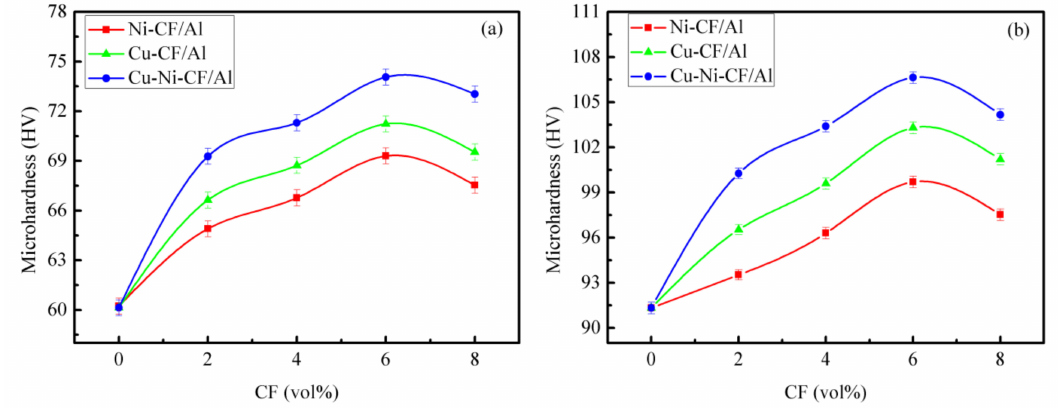
Figure 8. The hardness of di ff erent composites before and after heat treatment: ( a ) before heat treatment; and ( b ) after heat